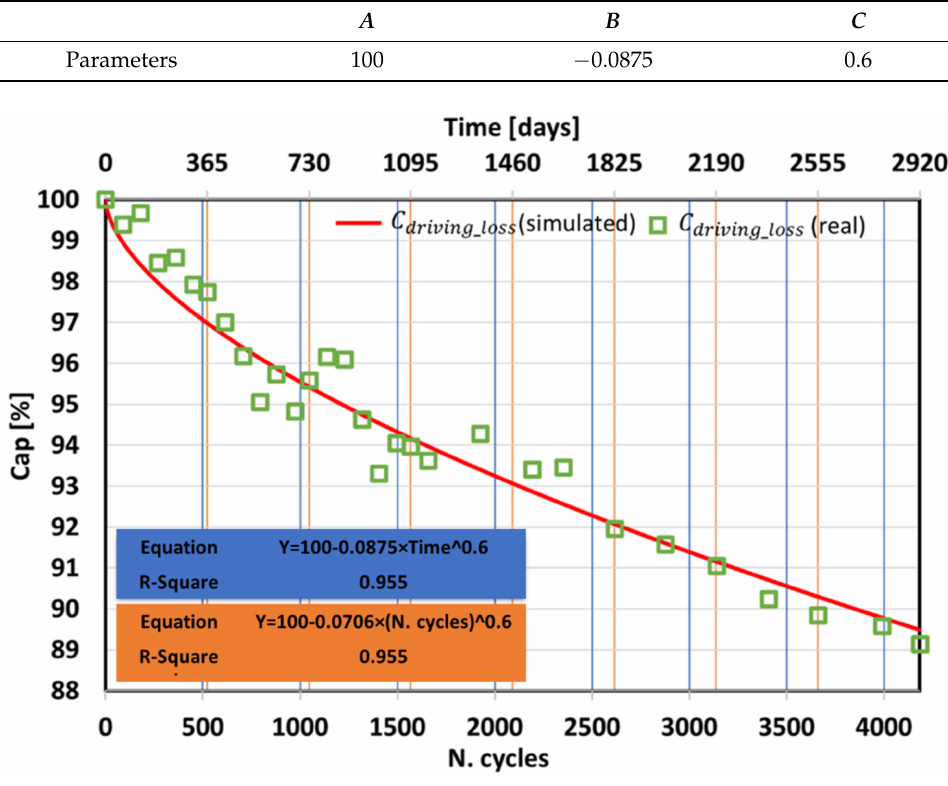
Figure 15. Loss of capacity from the number of driving cycle WLTP CLASS 3B and